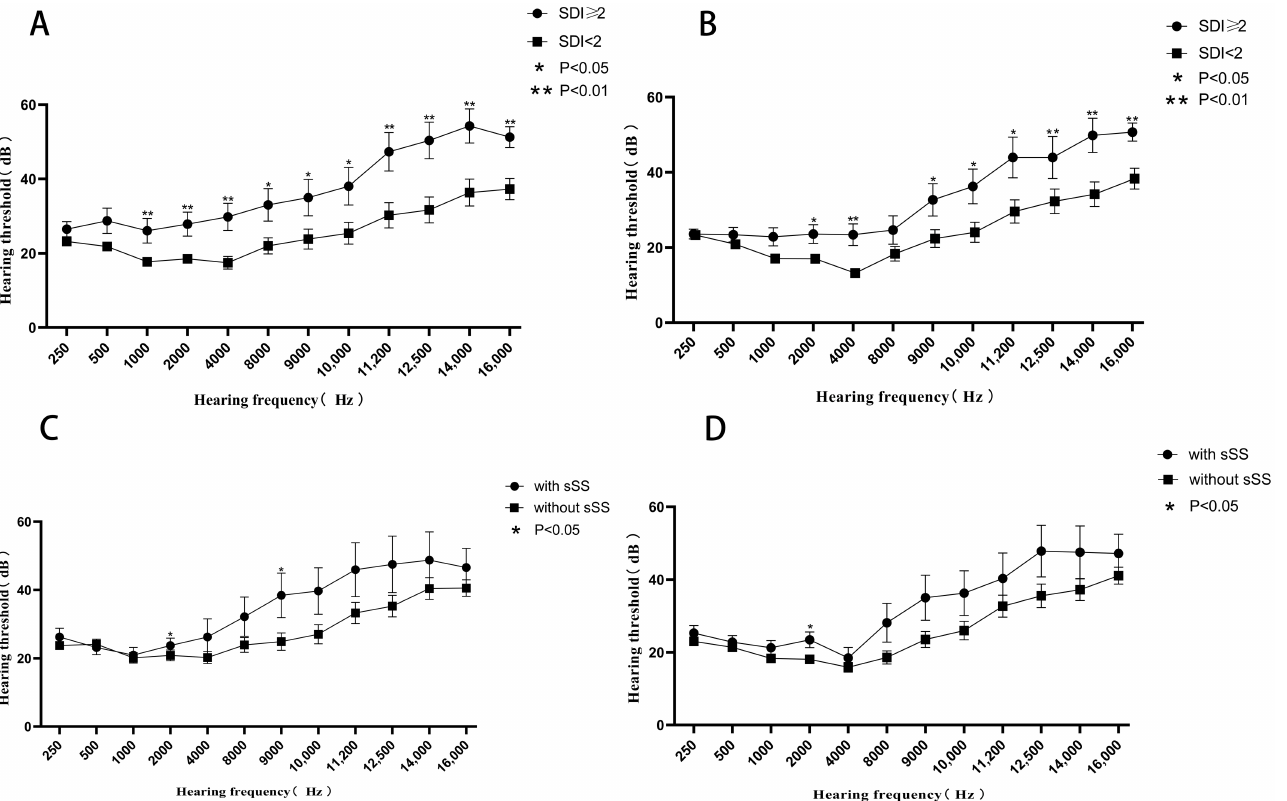
Figure 4. Hearing thresholds at different frequencies in SLE patients. ( A , B ) Comparison of hearing thresholds in SLE patients with SDI ≥ 2 ( n = 28) and <2 ( n = 63) in the left or right ear. ( C , D ) Compar- ison of hearing thresholds in SLE patients with ( n = 16) and without sSS ( n = 75) in the left or right ear. Data are presented as mean ± SEM and the mean values at each hearing frequency are linked by the trend line. * p < 0.05, ** p < 0.01 by t -test. SDI: Systemic Lupus International Collaborating Clinics/ACR damage index, sSS: secondary Sjögren’s